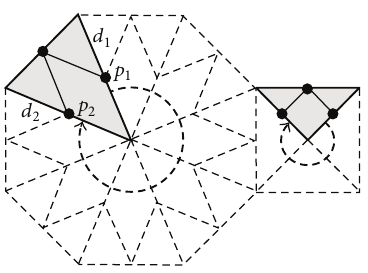
Figure 13: Point on segment control diagram (Type A).